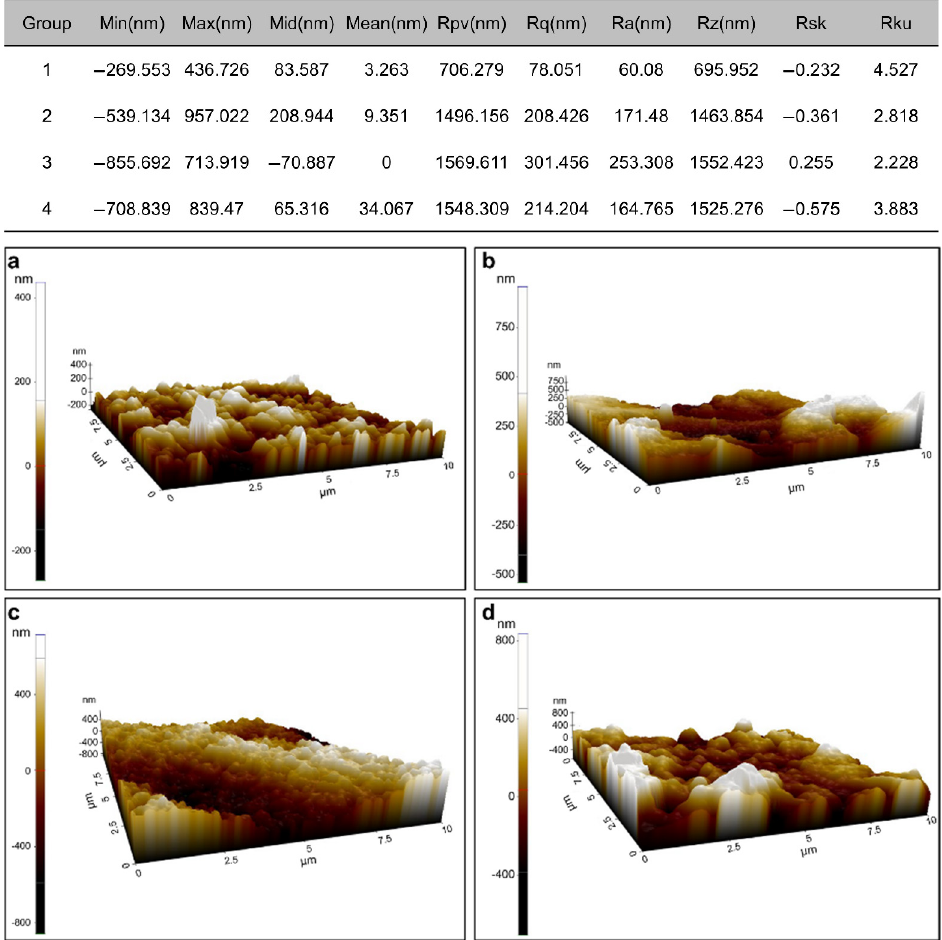
Figure 5. Representative atomic force microscopy (AFM) images of specimens belonging to various groups: ( a ) 1 (control), ( b ) 2 (air abrasion), ( c ) 3 (Zircos-E etching), and ( d ) 4 (ZirADD coating).